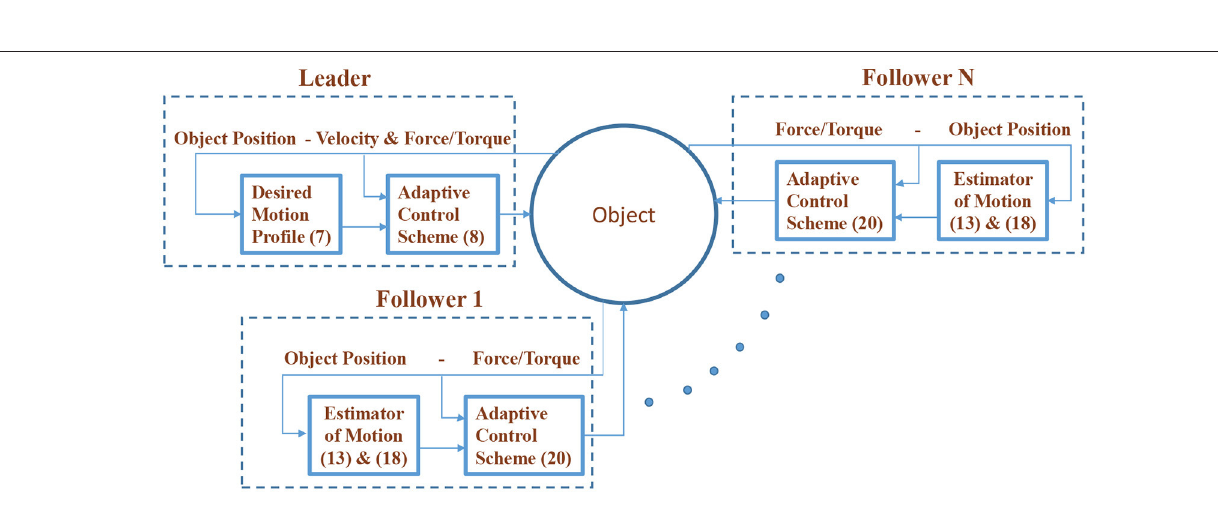
FIGURE 4 | The overall control